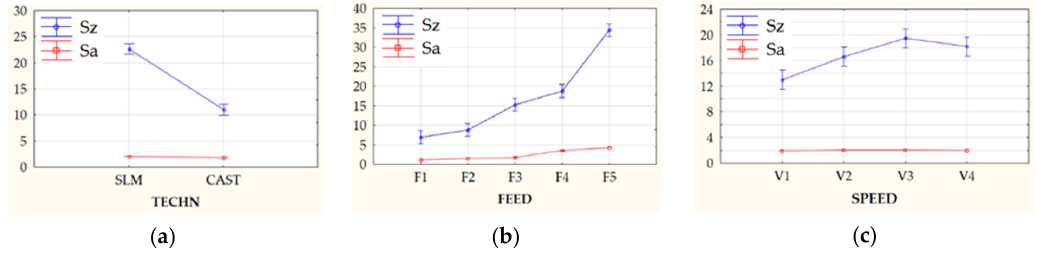
Figure 9. Changes in Sa and Sz parameters under the influence of main effects, where error bars indicate 95% confidence interval for the factor: ( a ) type of prefabricated element used—TECH, ( b ) feed speed—FEED; ( c ) cutting speed—SPEED.